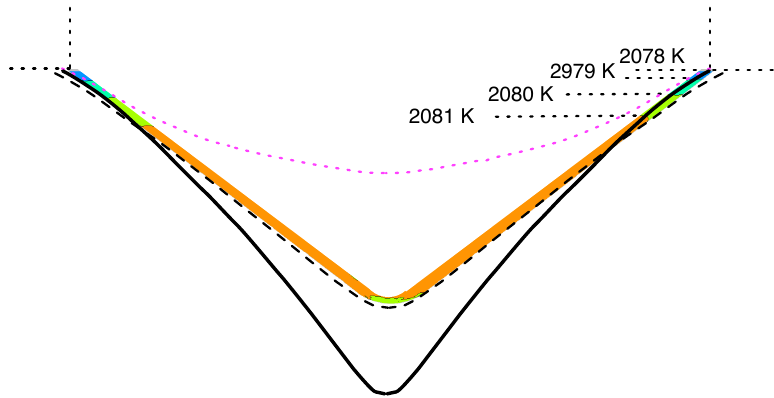
Figure 7. Comparison of interface shapes. The thick line with colours indicates the preset interface for the 3D calculations, and the colours exhibit the temperatures along this line from the computation for Case 1. The dotted line is the isoline of T = 2081 K. We used axisymmetric calculations with CGsim to compute the crystal–melt interface. The black line is the interface for the same case as the 3D one. The dotted line in magenta is the interface for the case without melt